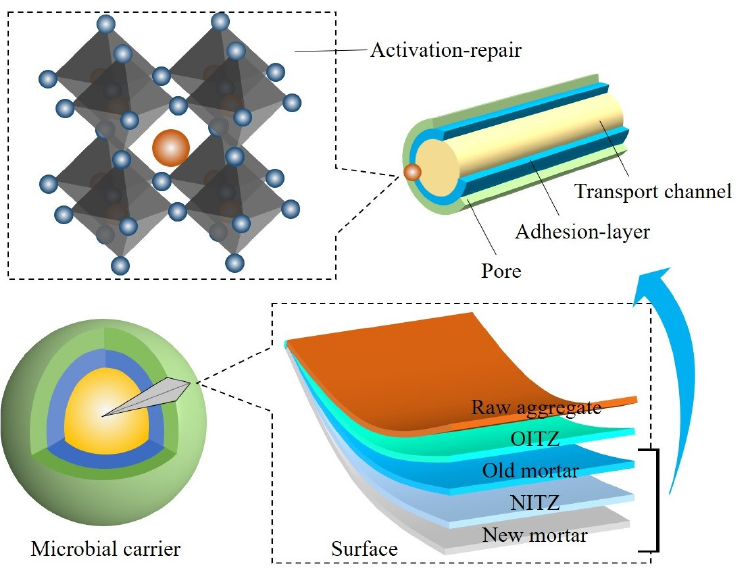
Figure 10. Schematic representation of the microbial carrier interface to generate products. The RCA and RFA at the fractures were wrapped by the repair products, which were found via SEM, as shown in Figure 11. There were almost no repair products or hydration products (C-S-H) at the raw aggregate interface, which was due to the density and high strength of the raw aggregate, and it was extremely difficult for microorganisms to adhere to the exposed surface of the raw aggregate. The OM was abundantly distributed on the carrier surface, and the repair products were attached to the old mortar and extended outward. The larger the volume of the OM, the larger the particle size and total repair products, which indicates that the old mortar directly influences the distribution pattern and the total amount of CaCO 3 produced by the attached microorganisms.